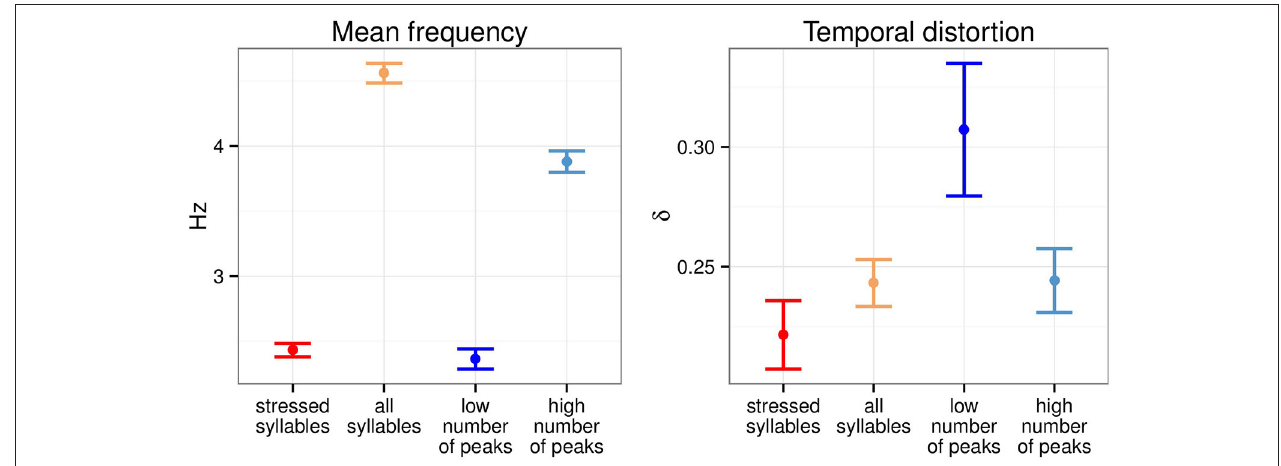
FIGURE 2 | Mean inter-anchor point frequency and temporal distortion across four temporal modification conditions. Errobars, here and elsewhere, show 95 % confidence intervals ( N = 190).